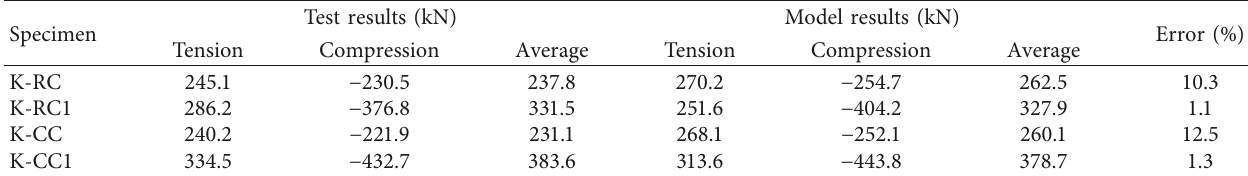
Table 5: Comparison between test results and model